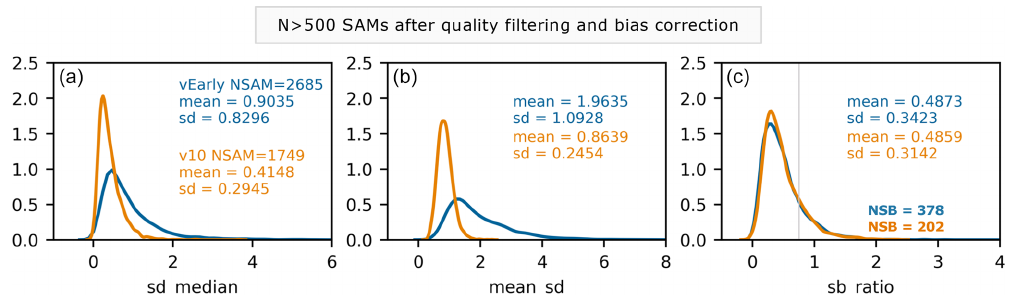
Figure 19. Normalized histograms of swath bias parameters for vEarly and v10 SAMs, using v10 sounding selection for both datasets. All SAMs have at least 500 soundings ( N > 500). The number of SAMs in each dataset is given by NSAM. vEarly is in blue, v10 is in orange, and the SB threshold of sb_ratio > 0.75 is indicated by the gray line. The number of swath bias cases is listed as NSB in panel (c) .